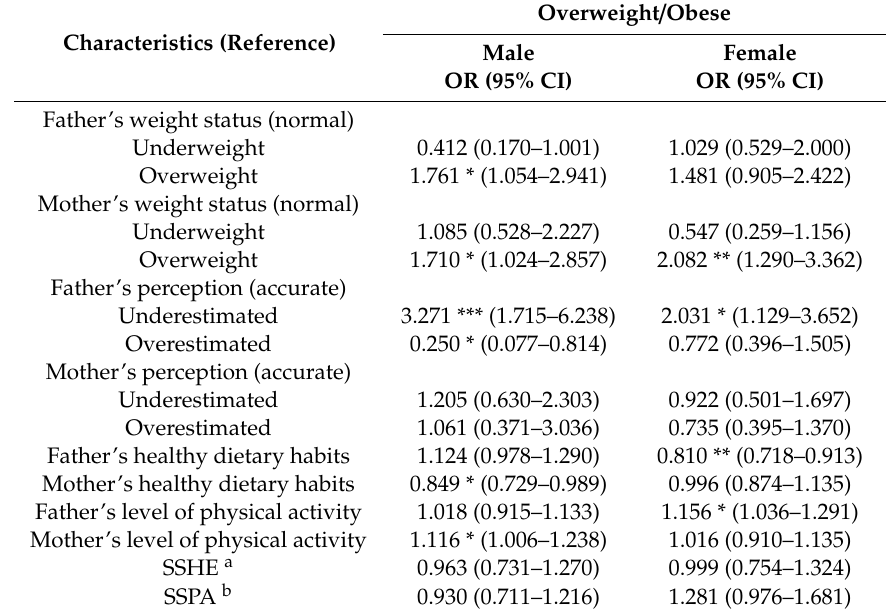
Table 2. Logistic regression model for overweight / obese status among adolescents by